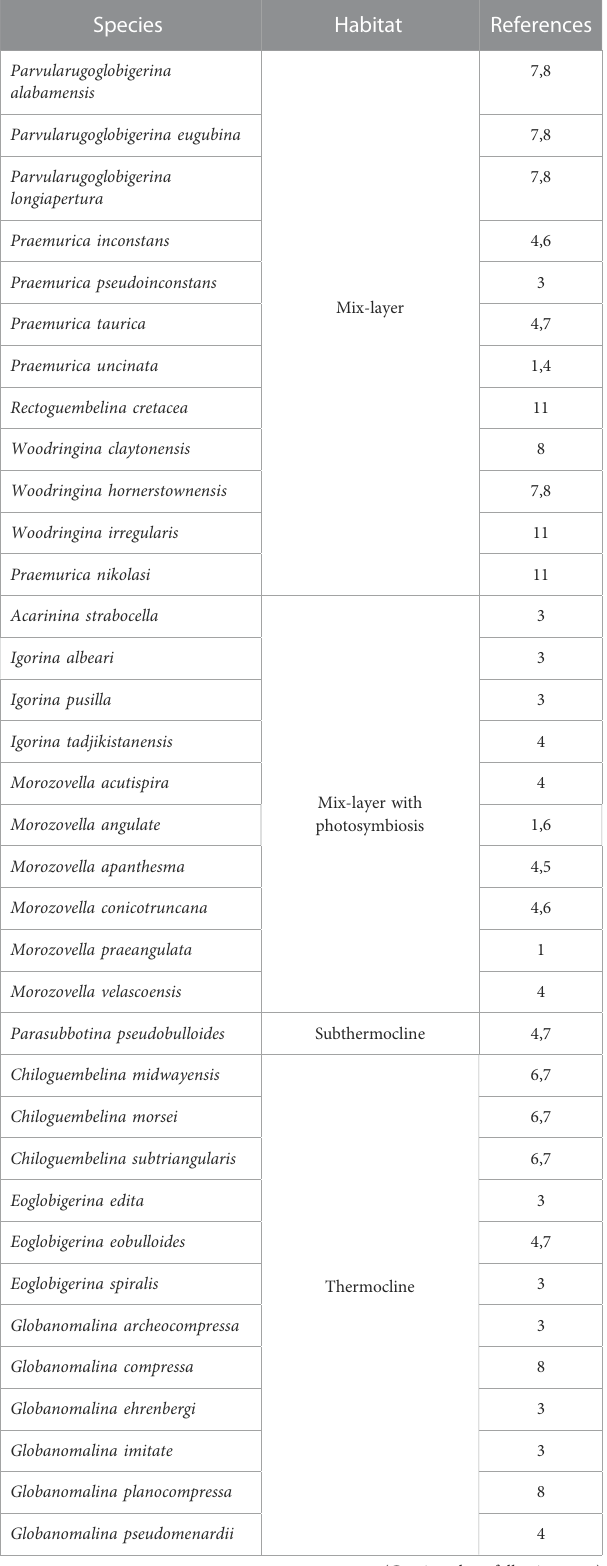
TABLE 1Paleoecological signi fi canceofspeciesidenti fi edinthe present study. 1, Shackleton (1985); 2, D ’ Hondt et al. (1994); 3, Aze et al. (2011); 4, Berggren and Norris (1997);5,Lu andKeller (1996);6, Boersma and Premoli Silva(1983); 7, D ’ Hondt and Zachos (1993); 8, Olsson et al. (1999); 9, Pearson et al. (2001); 10, Coxall et al. (2000); 11, Huber and Boersma (1994).